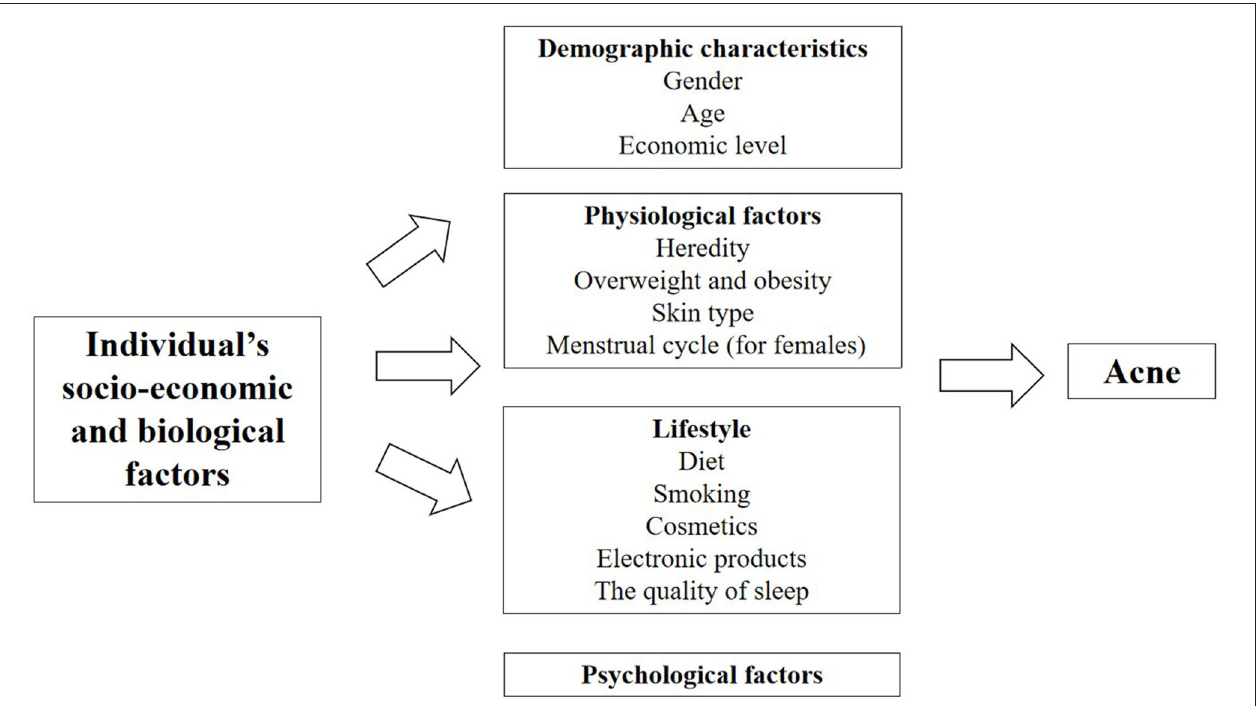
FIGURE 2 | Factors of individual’s socio-economic and biological factors affecting